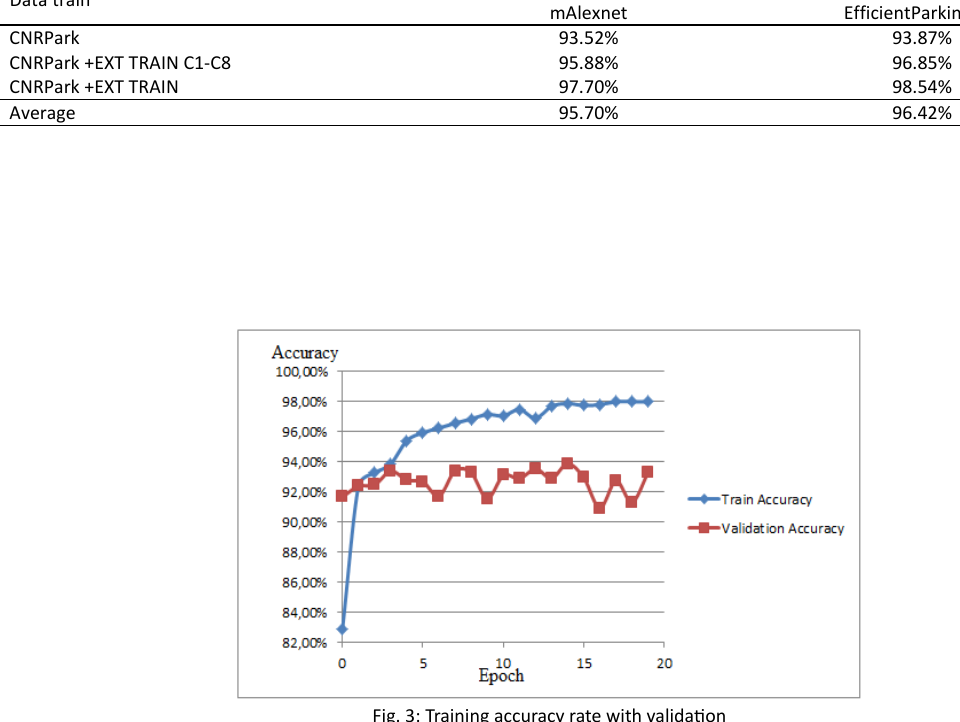
Fig. 3: Training accuracy rate with validation